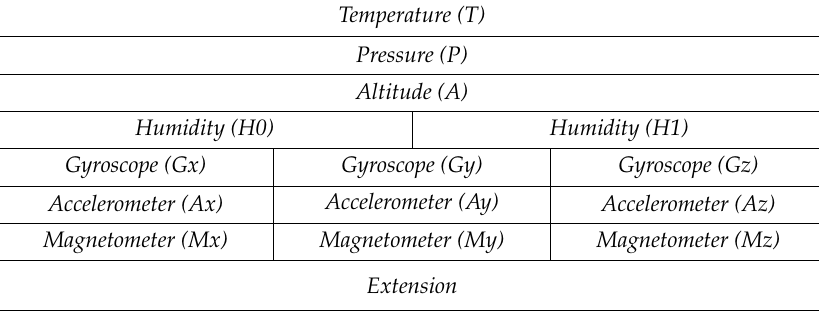
Figure 4. Sensor node to edge gateway data transmission packet format.